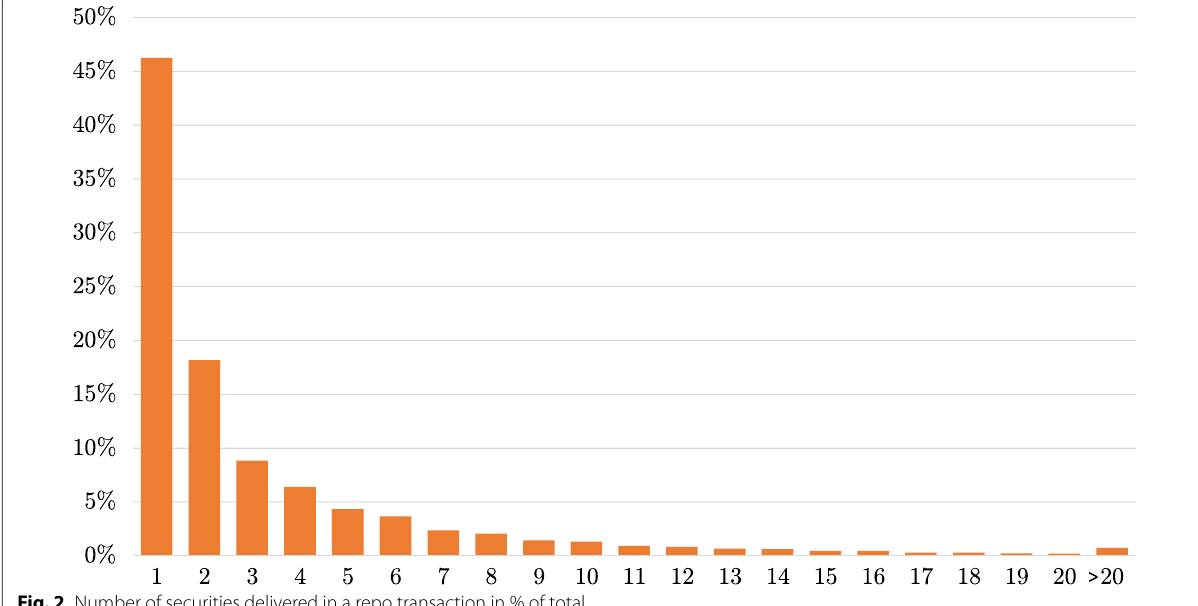
Fig. 2 Number of securities delivered in a repo transaction in % of total